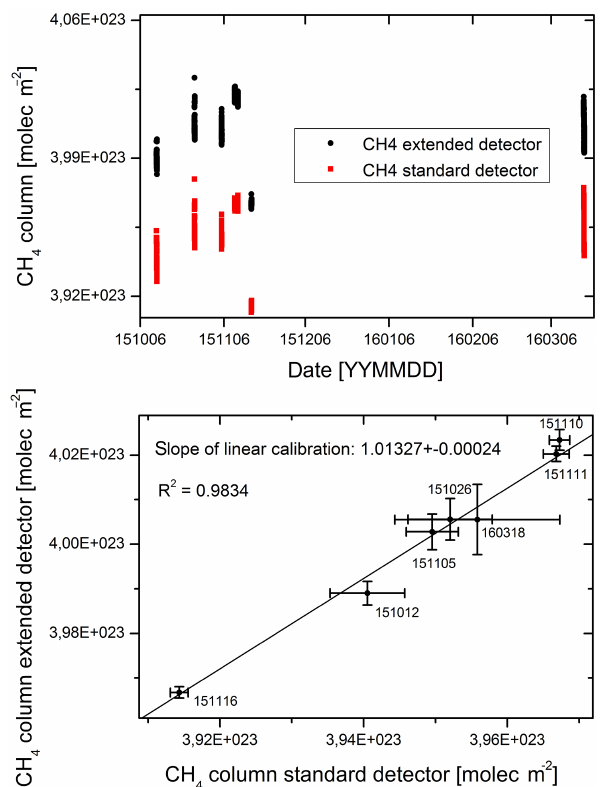
Figure 9. Comparison of methane column amounts as derived from the primary and secondary spectral channel. Upper panel: time series of methane columns. Lower panel: daily mean values of methane columns derived from the extended detector as a function of the methane columns derived from the standard detector. The er- ror bars are the standard deviations of the intraday scatter. A linear fit of the calibration factor suggests a systematic spectroscopic off- set of 1.013. There is no indication of a drift of the instrumental characteristics of the extended detector results with respect to the standard